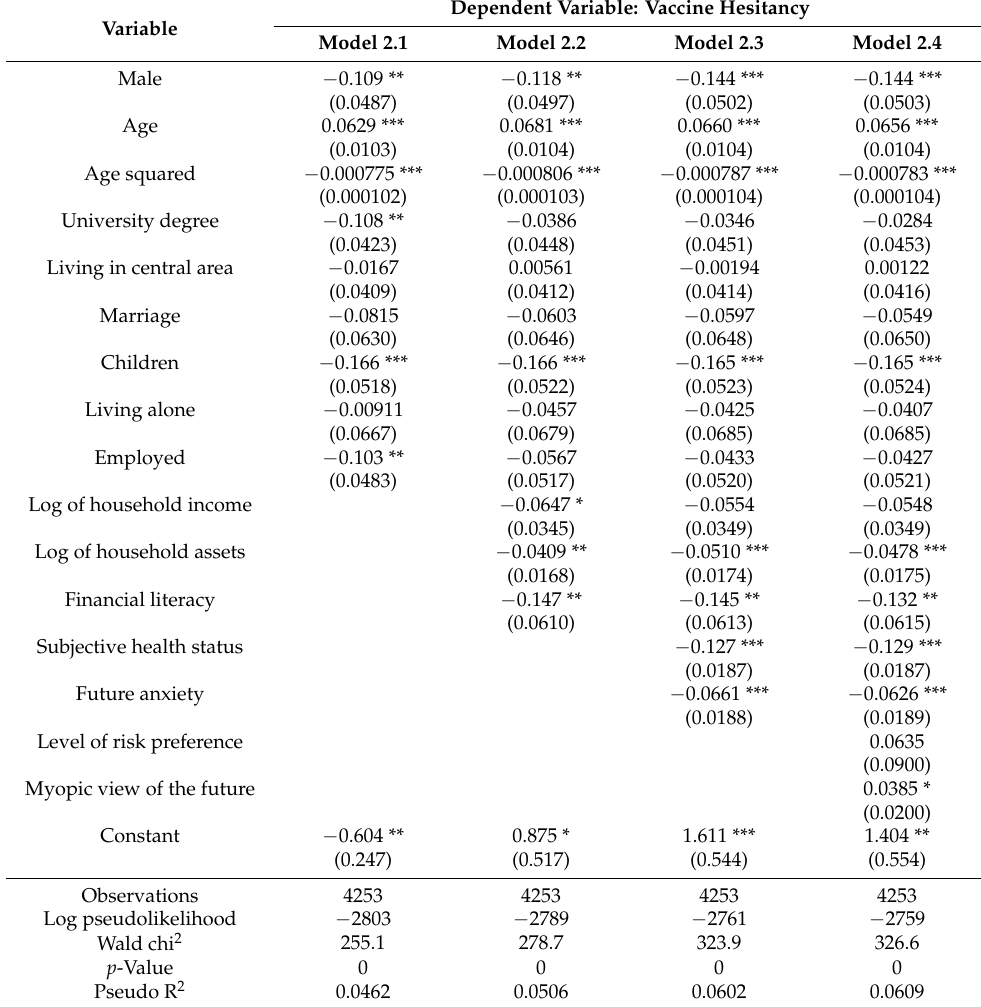
Table 6. Probit model regression results (full sample